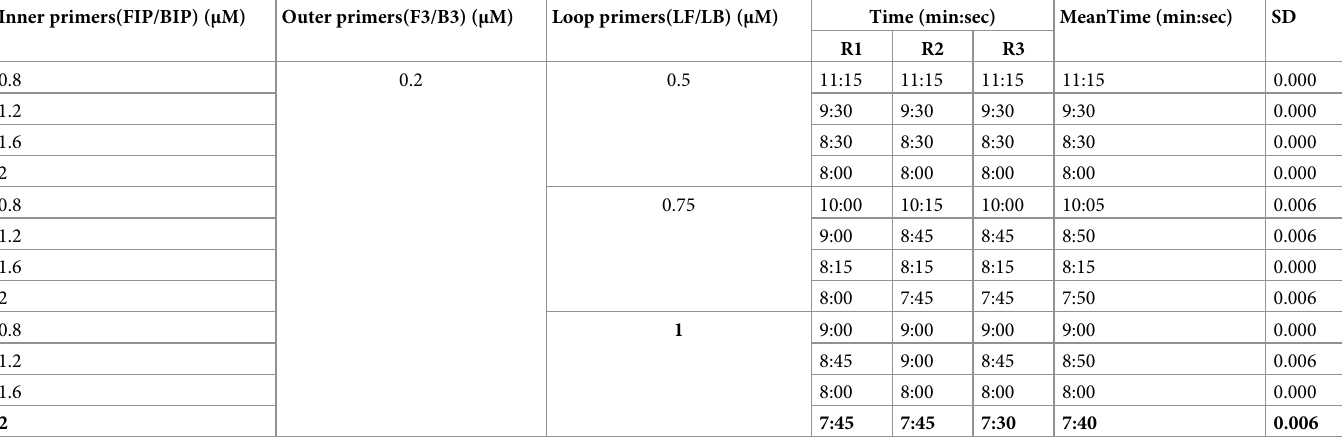
Table 3. Optimization of primer concentrations for RT-LAMP assay for VT strains of Citrus tristeza virus . Inner primers(FIP/BIP) ( μ M) Outer primers(F3/B3) ( μ